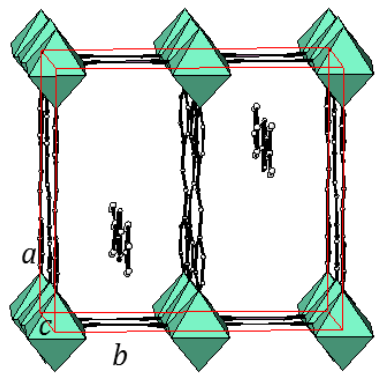
Figure 8. The Bpene ligands bridge the 2-D Ni[Ni(CN) 4 ] sheets to form the 3-D pillared-layered structure (C-grey, N-blue, Ni-green).